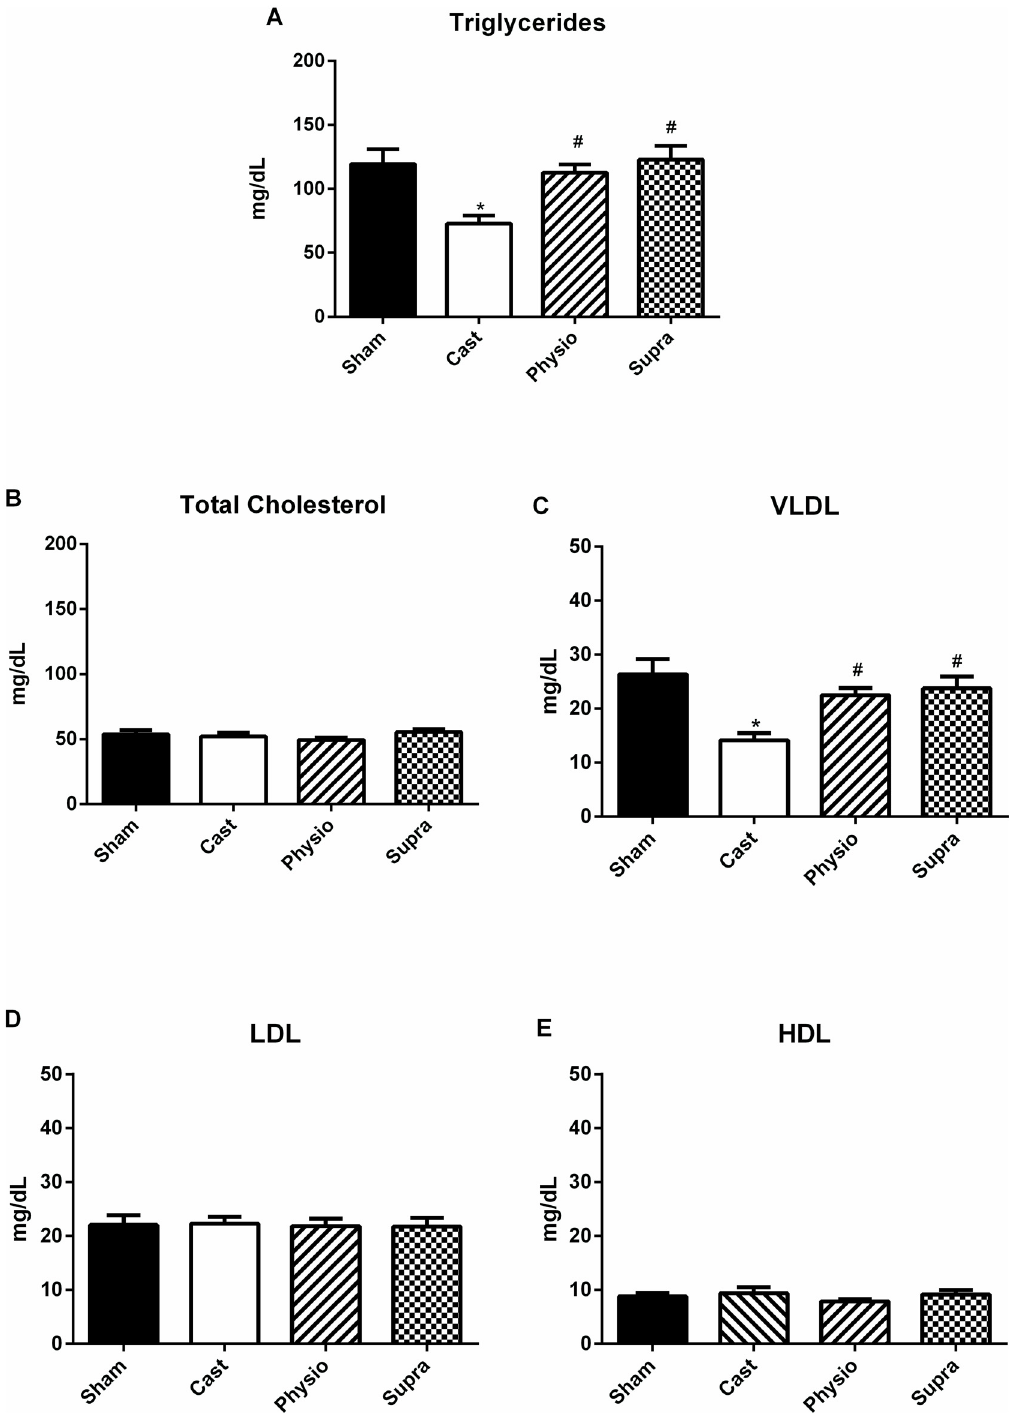
Fig 5. Lipid profile of normotensive rats. A) Triglycerides, B) total cholesterol, C) very-low-density lipoproteins (VLDL), D) low-density lipoprotein (LDL) cholesterol, and E) high-density lipoprotein (HDL) cholesterol in the SHAM (n = 15), CAST (n = 17), PHYSIO (n = 17), and SUPRA (n = 16) groups. Data are expressed as the mean ± SEM. * p < 0.05 compared with the SHAM group, #p < 0.05 compared with the CAST group.